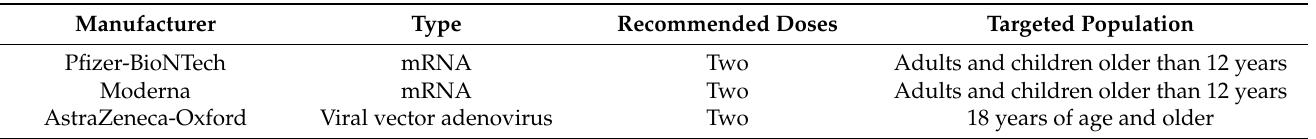
Table 1. Approved and used COVID-19 vaccines in Saudi Arabia (data from the Saudi Public Health Authority [17]). Manufacturer